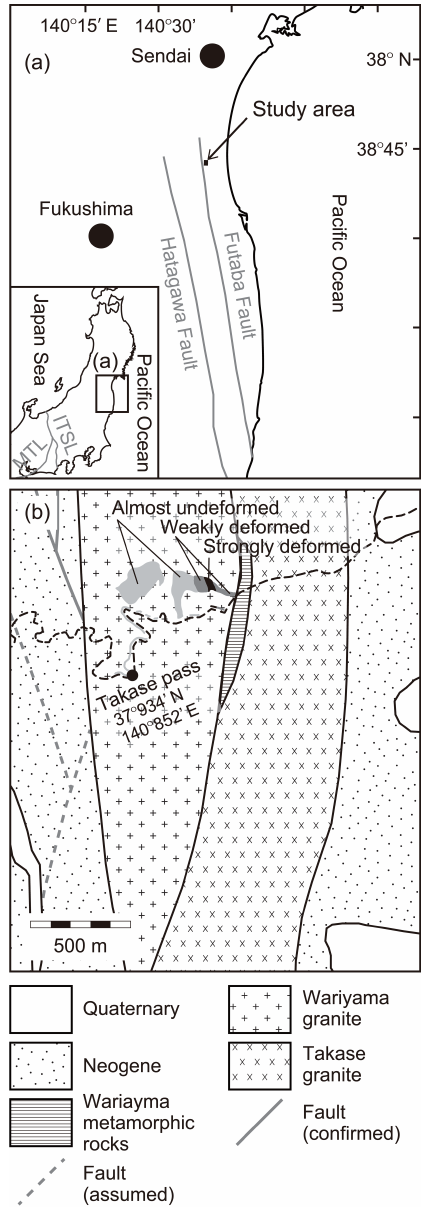
Figure 1. Study area location map (a) and geological map (b) of northeastern Japan after Oide and Fujita (1975), Fujita et al. (1988), and Tsuchiya et al. (2014). The inset in (a) shows the location of (a) in Japan and major tectonic lines (the Itoigawa–Shizuoka Tec- tonic Line (ISTL) and the Median Tectonic Line (MTL)). In (b) , the dashed black line represents a path including Takase Pass. The solid black lines represent geological boundaries. The Wariyama granite was categorized into three types based on the degree of deformation, as observed in hand specimens (Fig. 2) and according to microstruc- tures observed under a polarizing microscope (Figs. 3 and 4). The three types are referred to as almost undeformed, weakly deformed, and strongly deformed, with distributions as shown in the geologi- cal